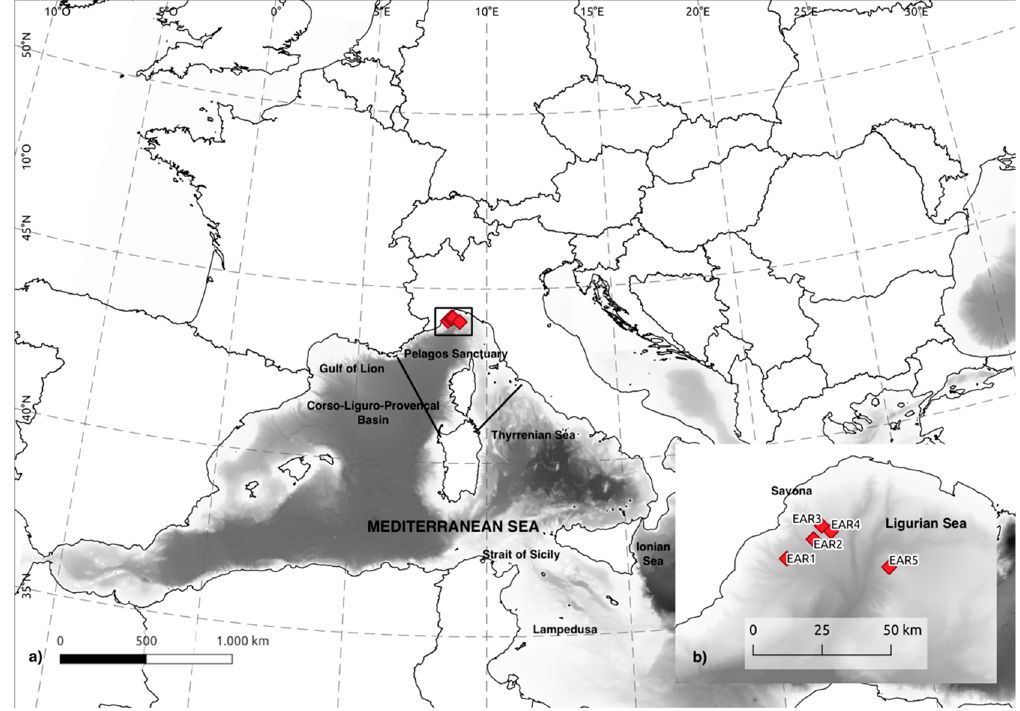
Figure 2. ( a ) The study sites in the western Mediterranean and ( b ) and the locations of the five EAR buoys in the Ligurian Sea